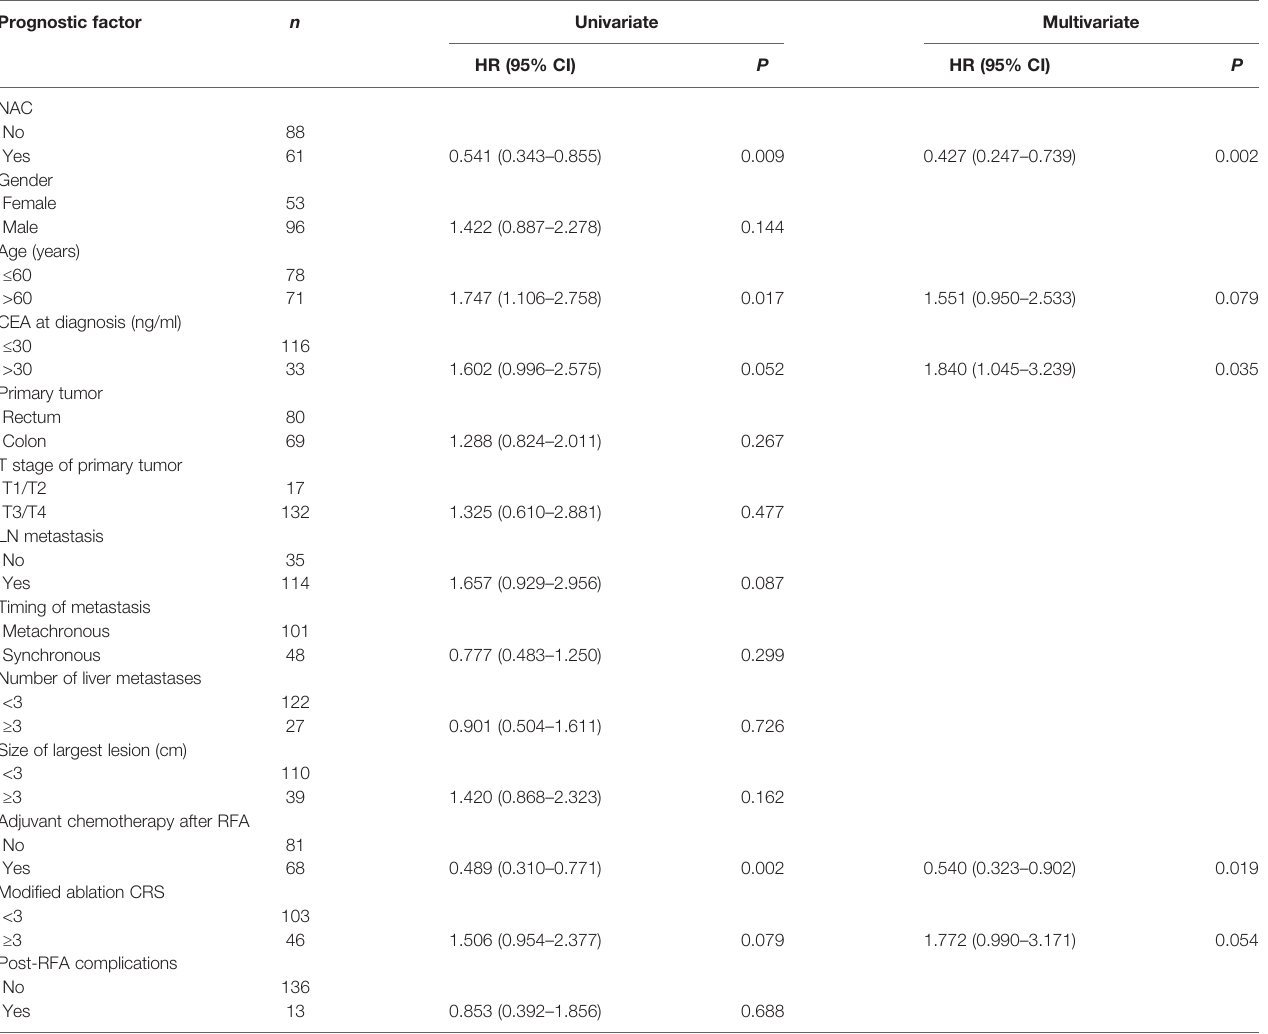
TABLE 6 | Analysis of prognostic factors associated with OS. Prognostic